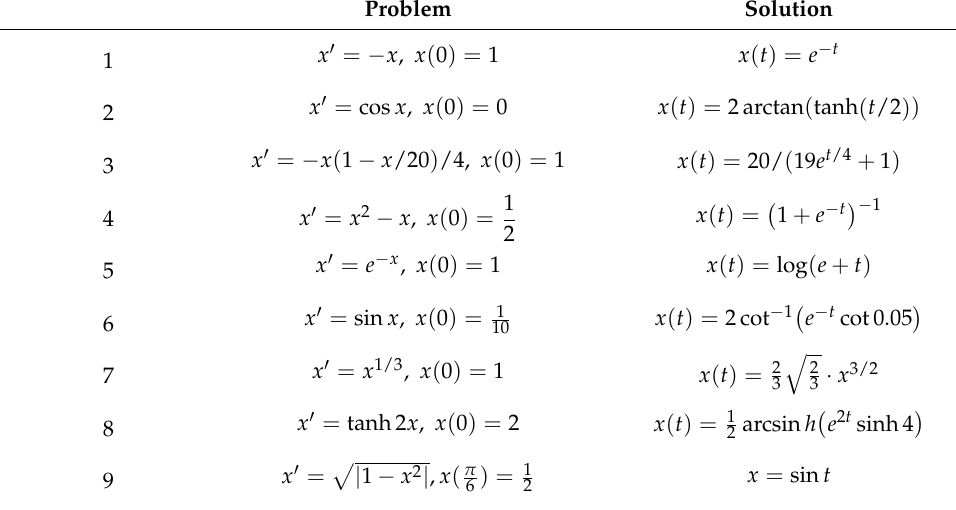
Table 2. Problems